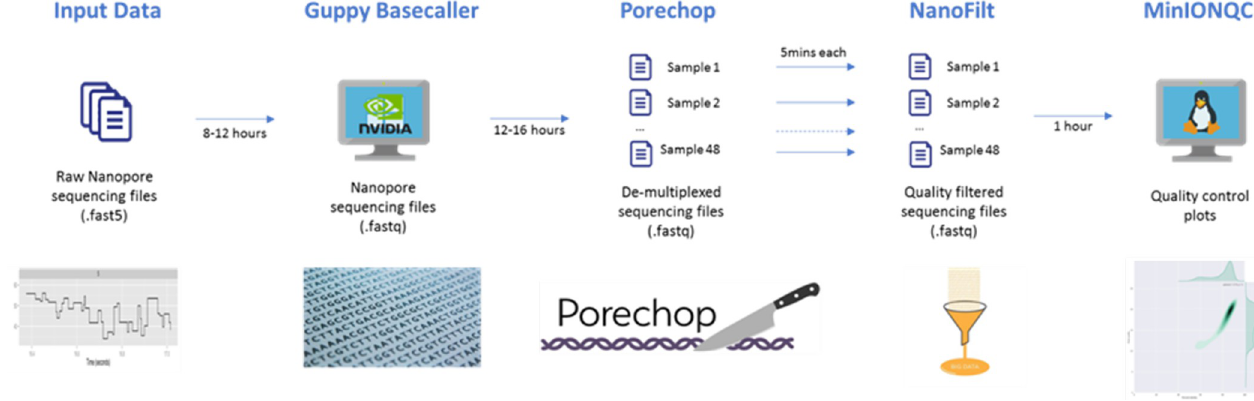
Fig 1. Overview of the analytic workflow for ONT